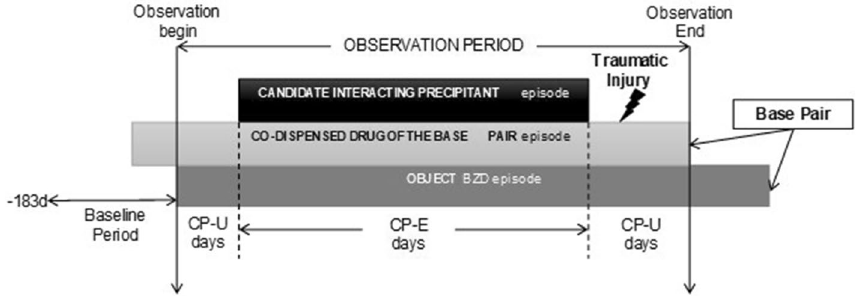
Figure 1. Example of benzodiazepine and related drug object + co-dispensed drug base pair exposure episode eligible for inclusion. BZD, benzodiazepine and related drug; CP-E, candidate precipitant-exposed; CP-U, candidate